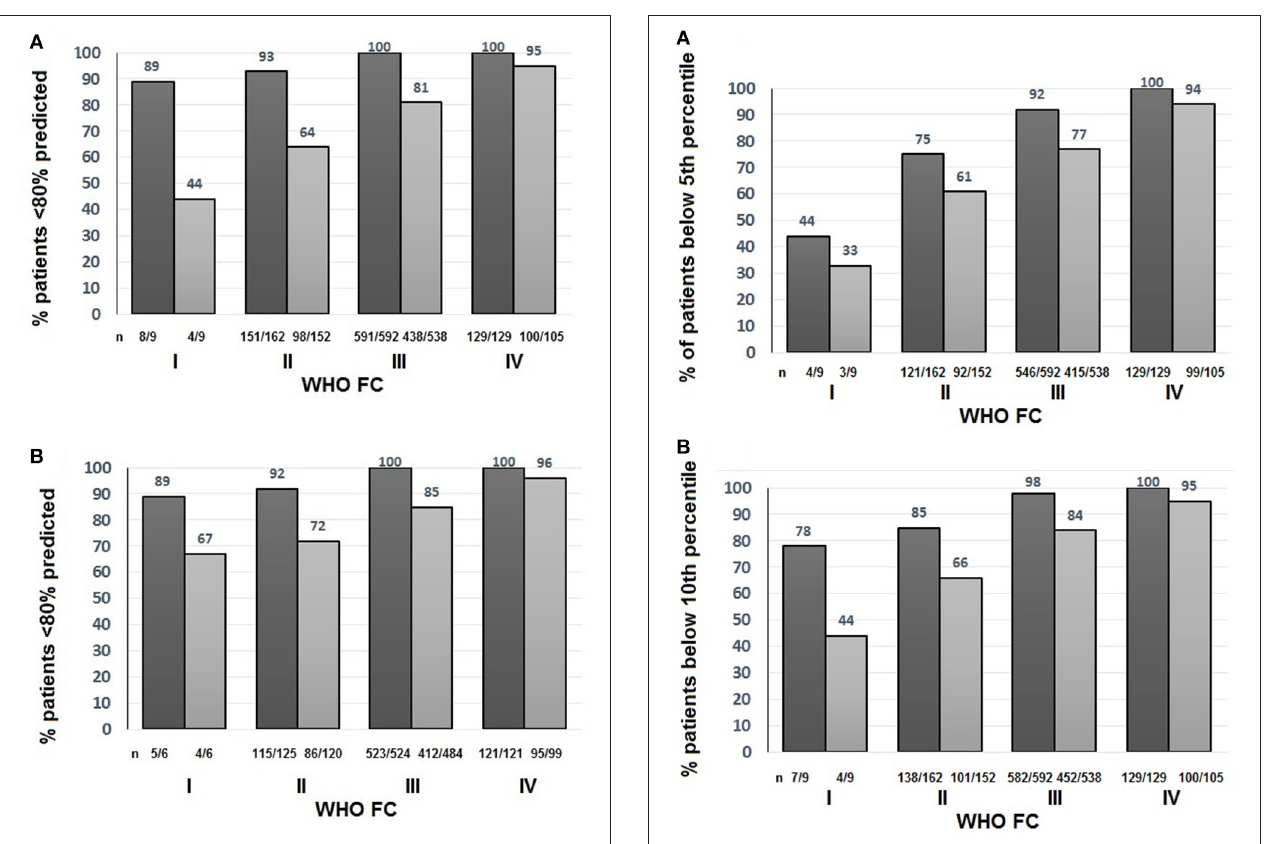
FIGURE 5 | Percentage of all patients with Incremental shuttle walk distance percent predicted (ISWD%pred) and Diffusing capacity across the lung for carbon monoxide percent predicted (DLco%pred) less than (A) the 5th percentile and (B) the 10th percentile World Health Organization Functional Class (WHO